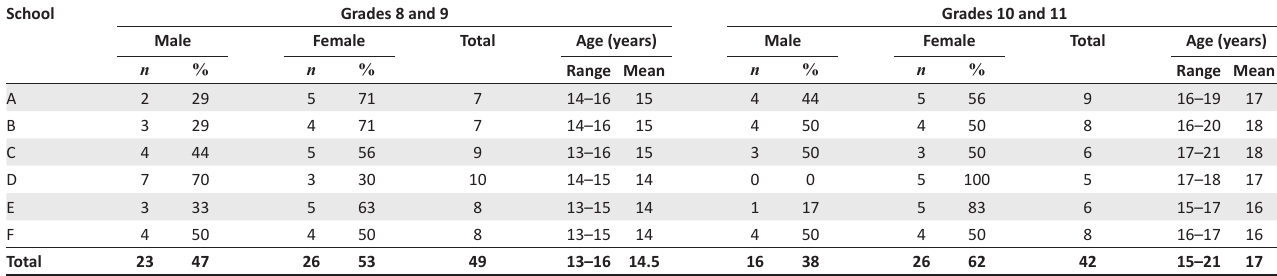
TABLE 2: Sex and age of focus-group discussions participants.